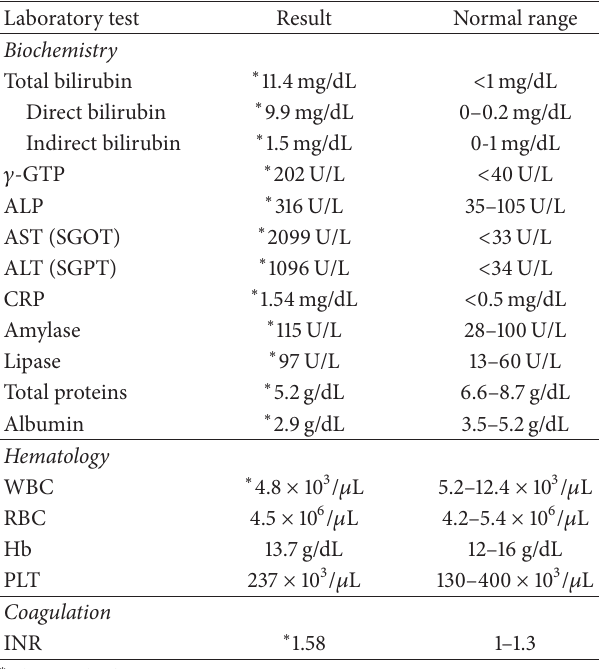
Table 1: Laboratory data upon